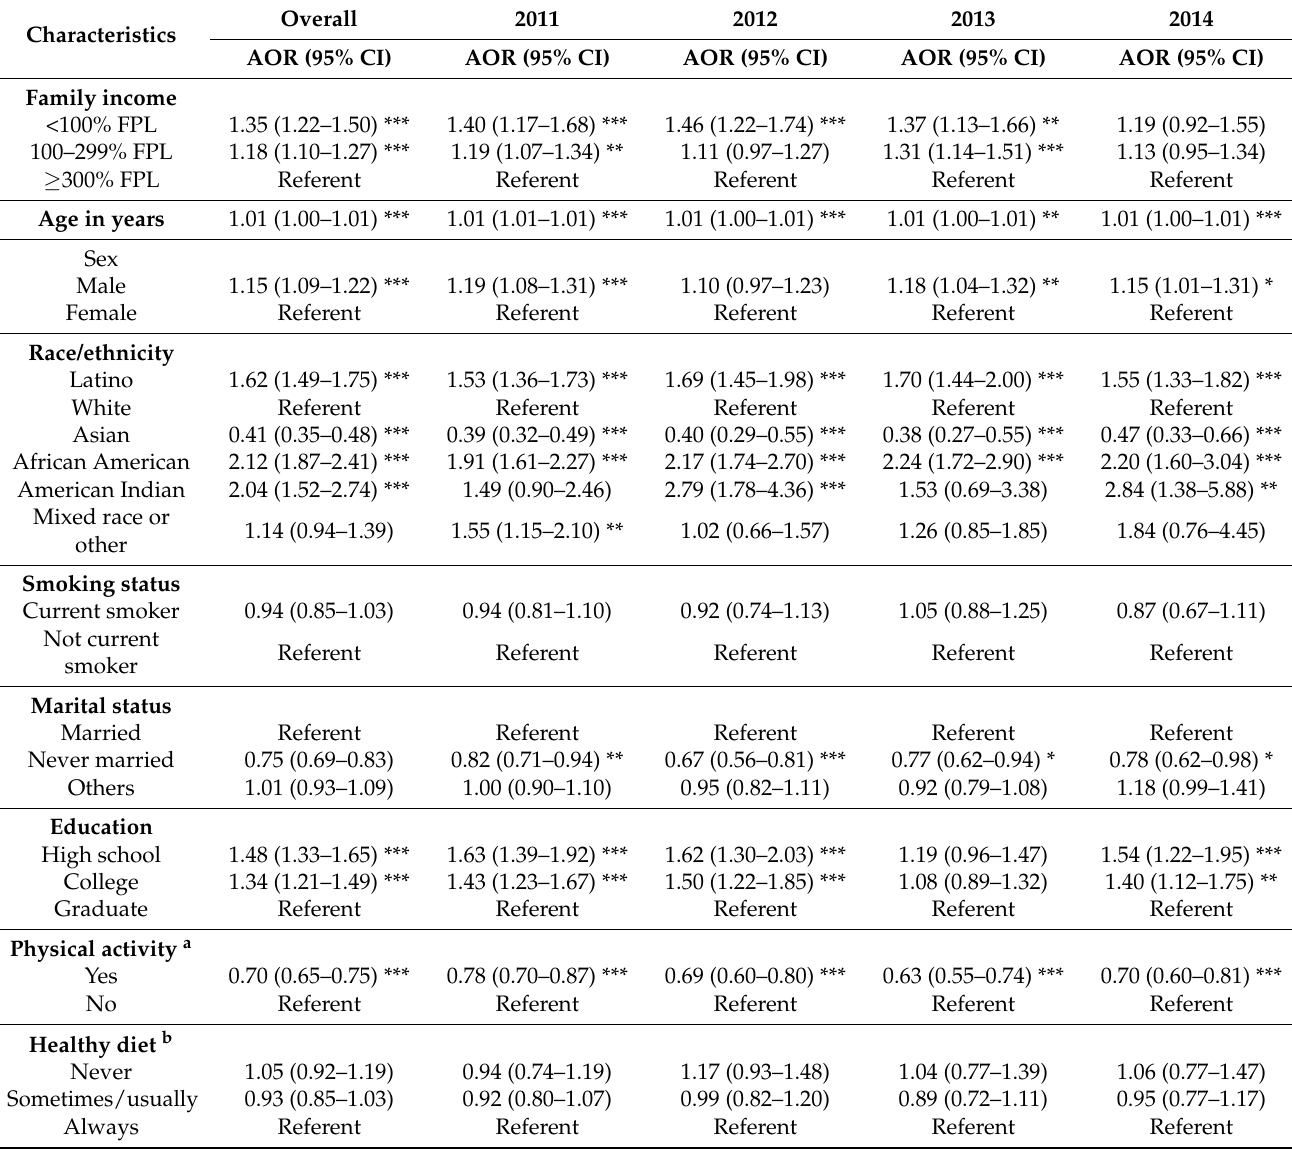
Table 2. Logistic regression analysis for the association between family income and obesity (vs. absence of obesity) among adults in California,